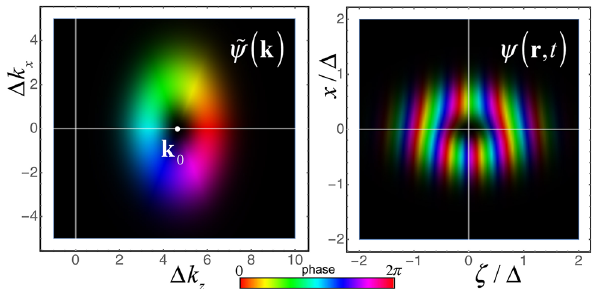
Figure 1: Phase-intensity distributions of the momentum-space (left) and real-space (right) wavefunctions of the STVP (1) and (2) with Δ = 0 . 7 and 𝛾 = 1 . 5. The brightness is proportional to the 𝓁 = 1, k 0 intensity | 𝜓 | 2 , while the color indicates the phase Arg( 𝜓 ) [47].